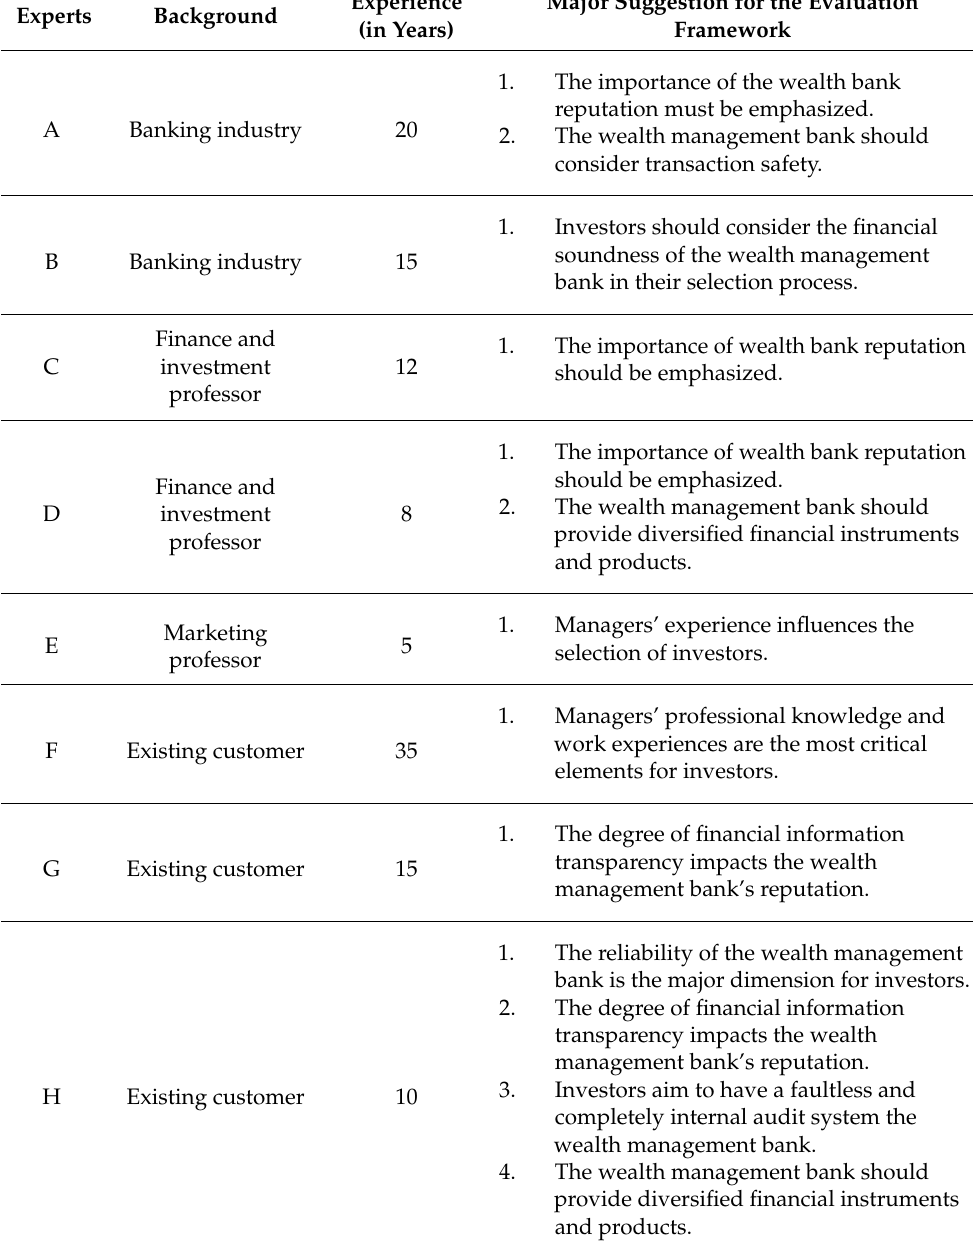
Table 1. Major proposal to assessment system from the expert